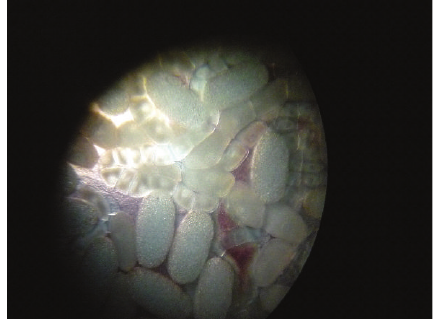
Figure 4: Optic microscopic view of Tunga penetrans eggs after excision of the flea from the foot